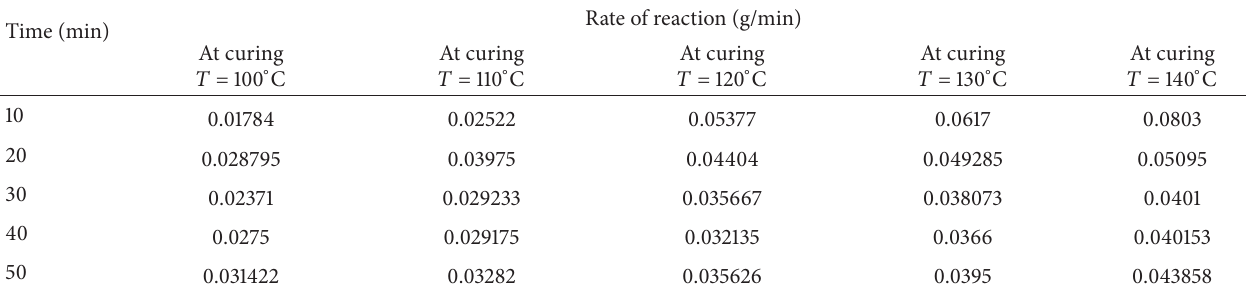
Rate of reaction (g/min) At curing At curing 𝑇 = 110 ∘ C 𝑇 = 120 ∘ C